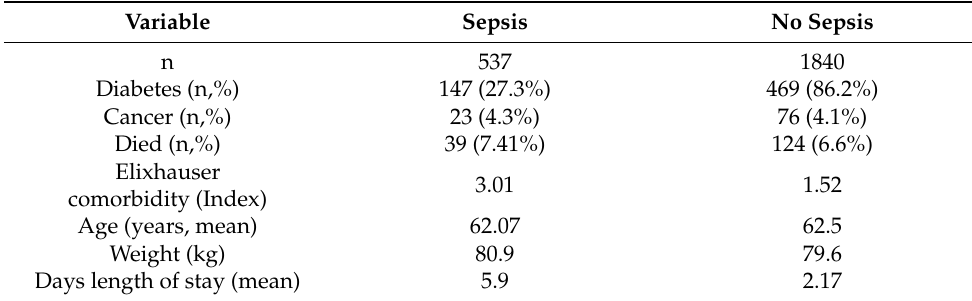
Table 1. Summary of characteristics of the populations included in the